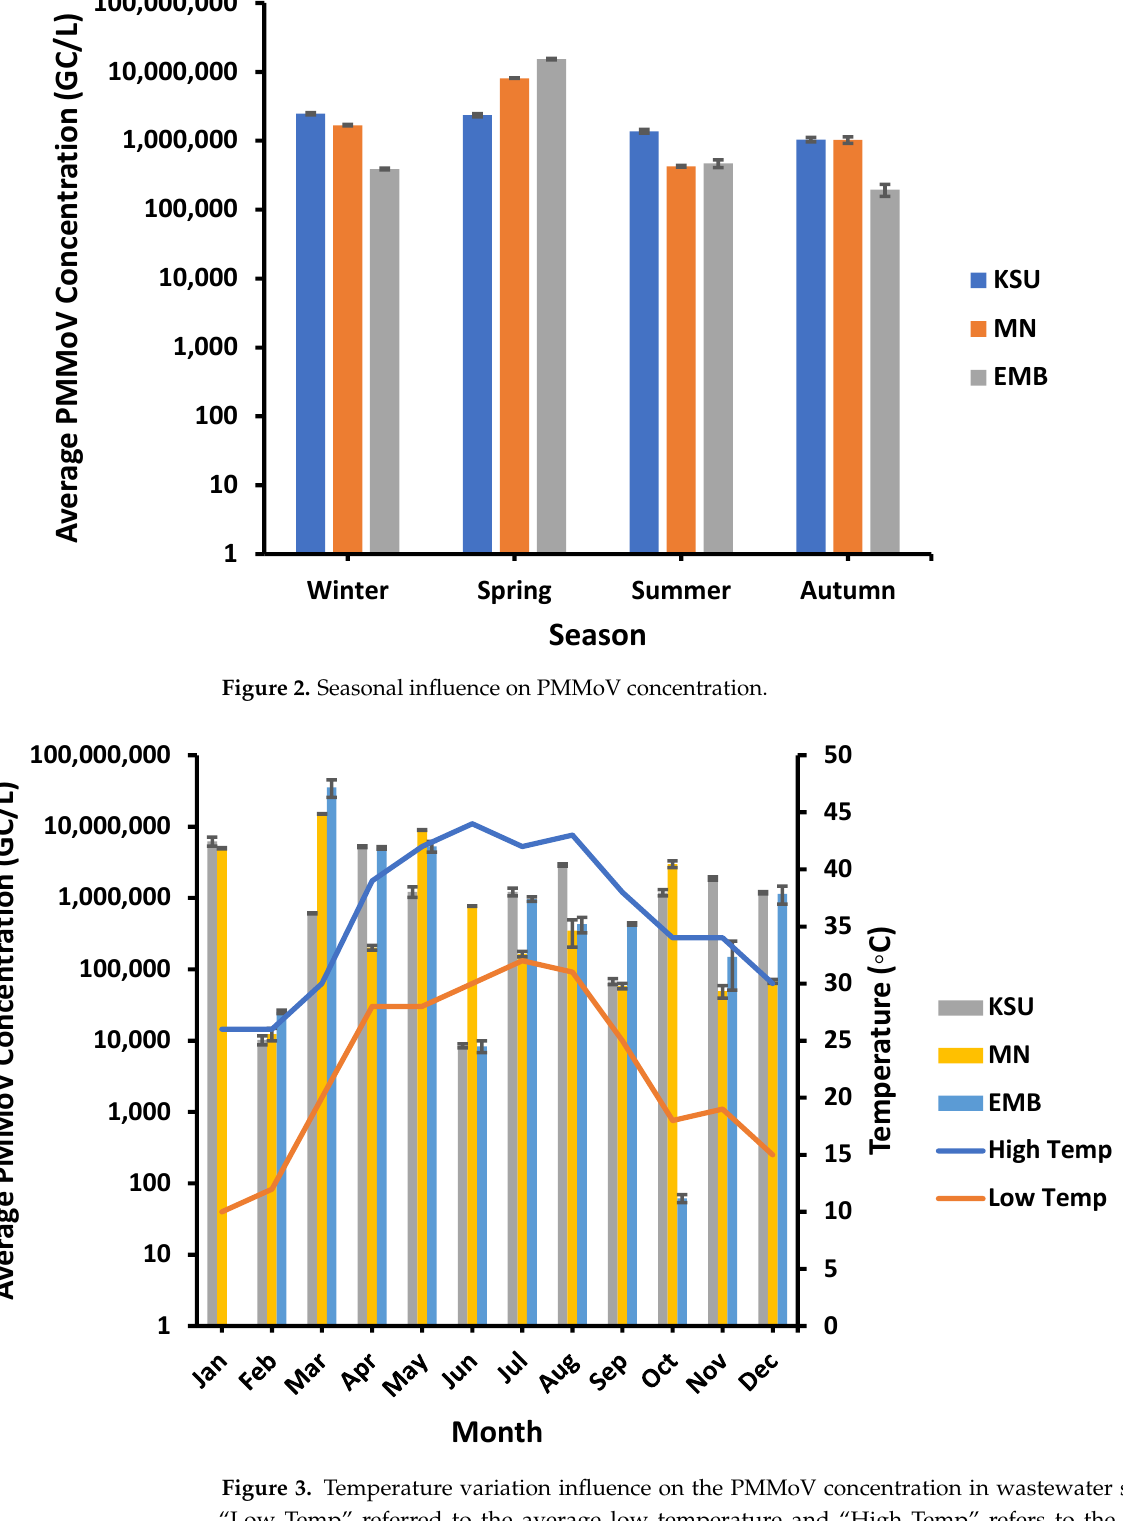
Figure 3. Temperature variation influence on the PMMoV concentration in wastewater samples. “Low Temp” referred to the average low temperature and “High Temp” refers to the average high temperature.